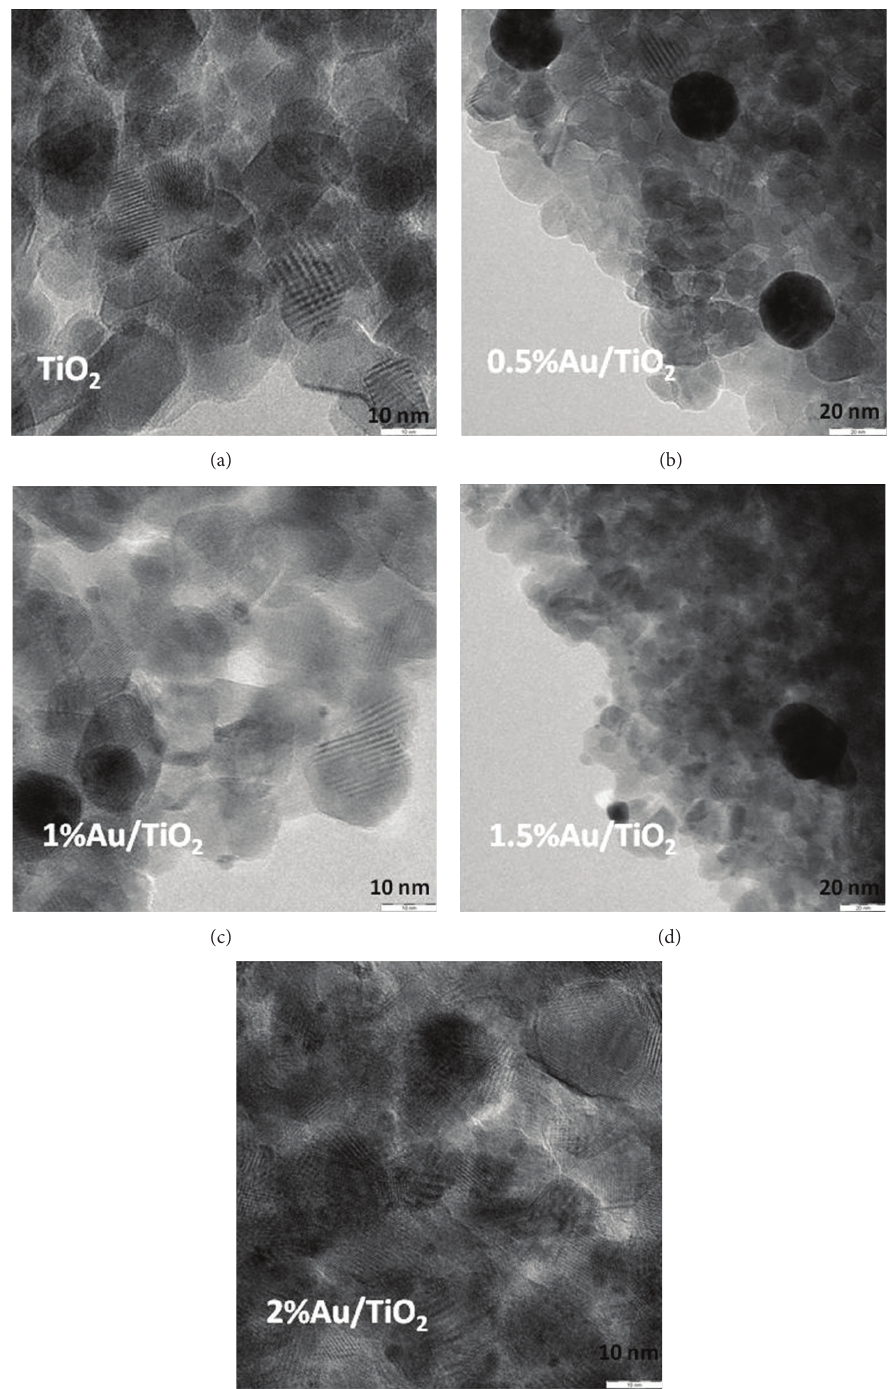
Figure 2: TEM image of TiO 2 and AuNP loaded TiO 2